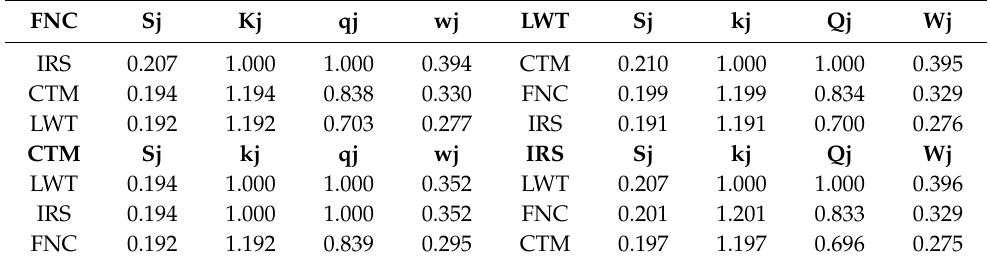
Table A10. Sj, kj, qj, and wj values for the relationship degrees of each perspective.